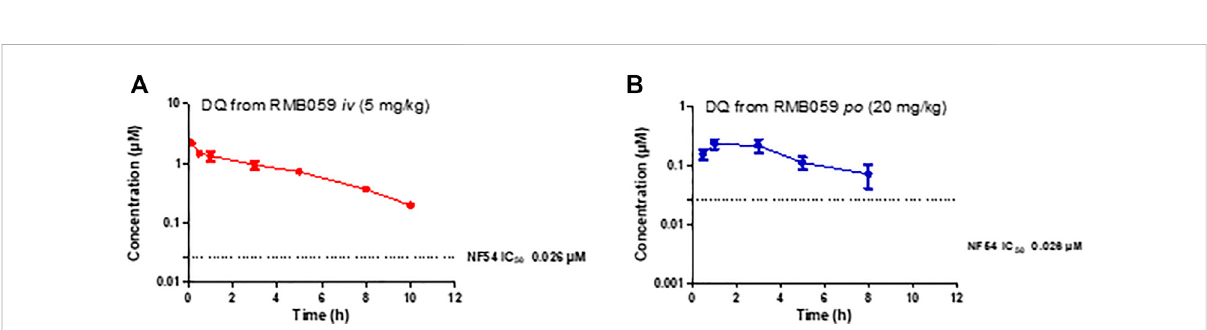
FIGURE 5 Mean± SEM concentration-timepro fi lesofDQfromRMB059 following (A) iv and (B) po administration.The dottedlinerepresentsIC 50 activity of DQ against Pf NF54.